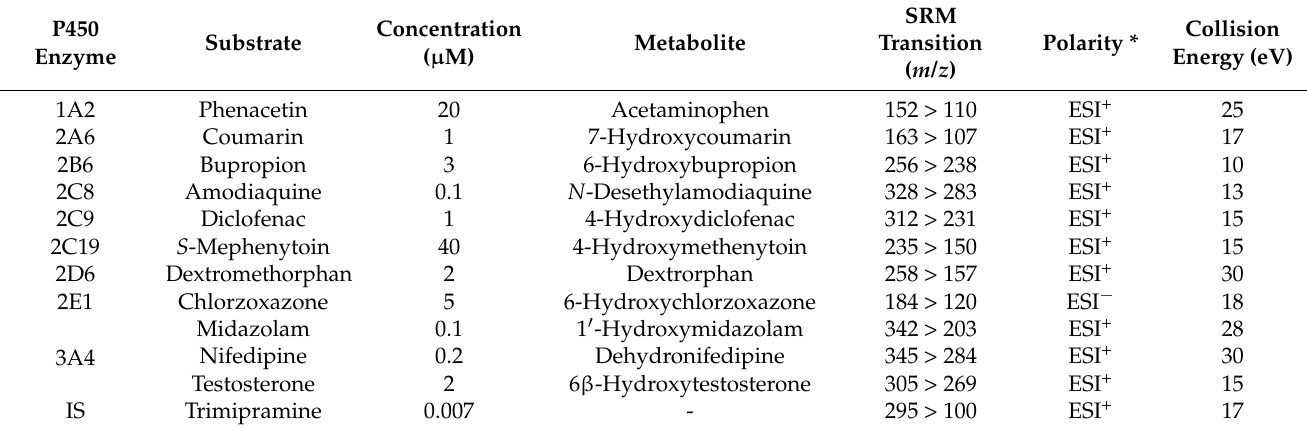
Table 1. Optimized selected reaction monitoring (SRM) parameters for metabolites of the nine P450 substrates and internal standard